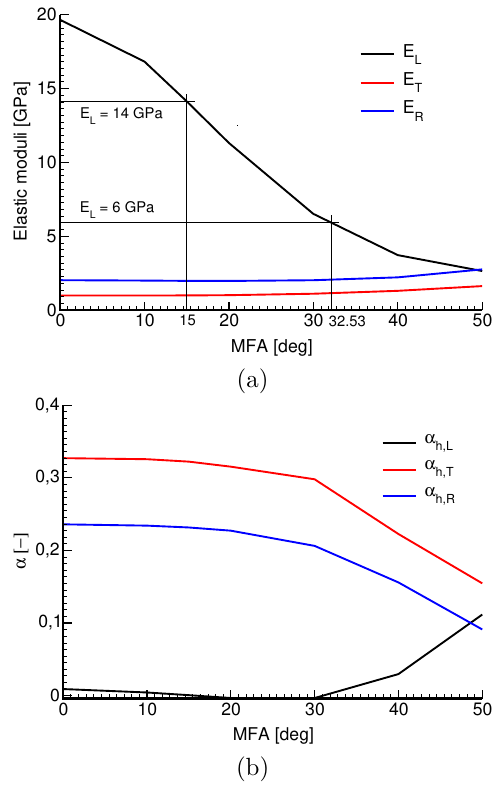
Figure 6. Variation of selected homogenized prop- erties as a function of MFA: a) elastic moduli, b) coefficients of